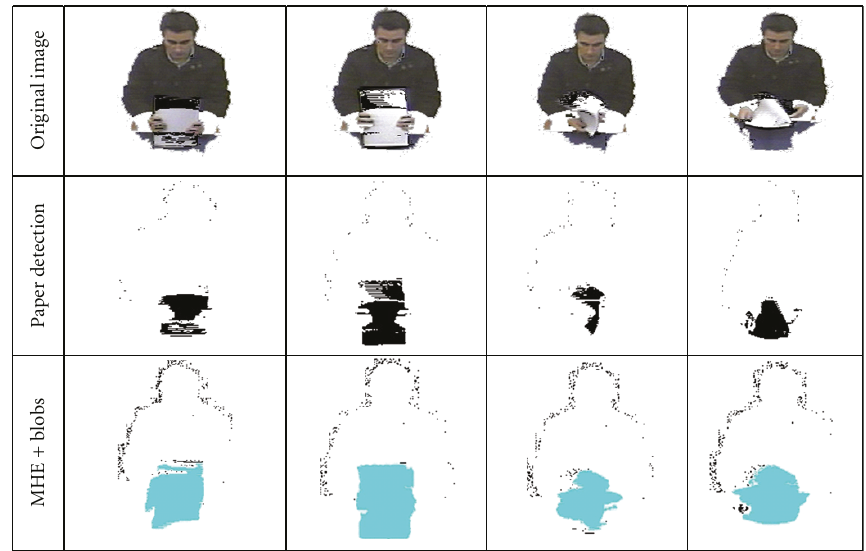
Figure 4: Paper wrapping feature